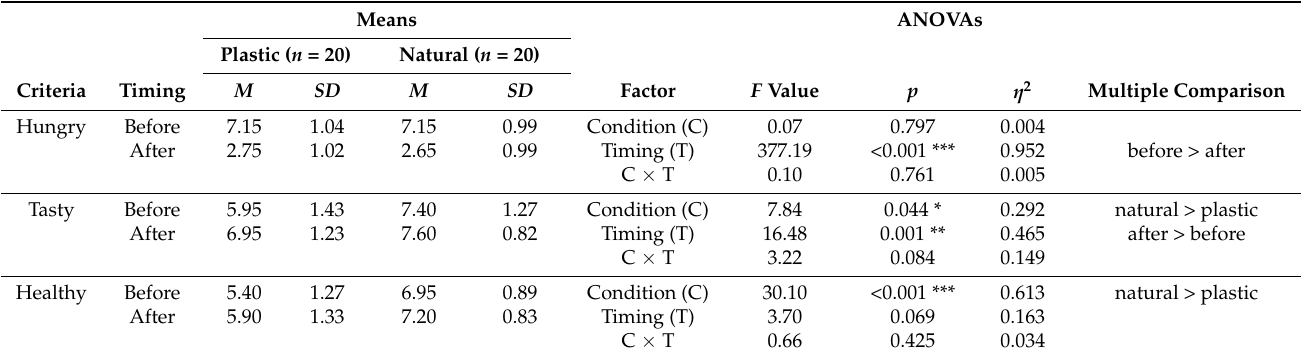
Table 1. Descriptive statics and two-way ANOVA